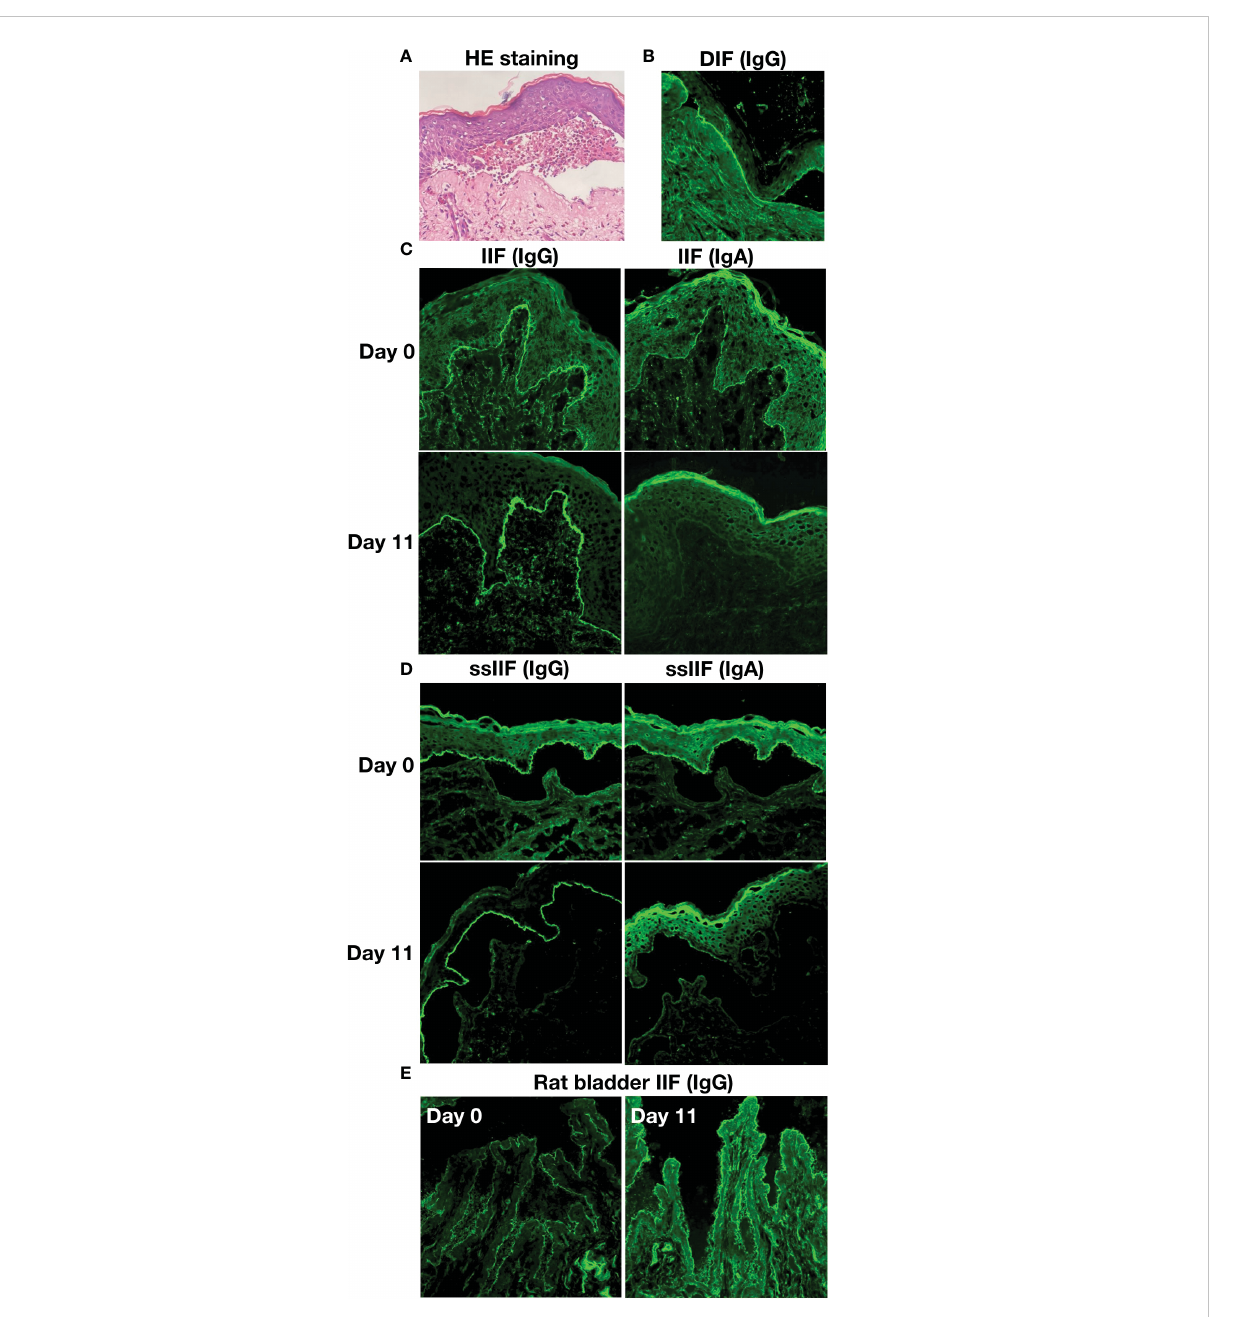
FIGURE 2 The results of histopathological and immuno fl uorescence tests of this patient. (A) Histopathological features of biopsy from lesioned skin on the left forearm (HE staining, original magni fi cation, x200). (B) Direct immuno fl uorescence (DIF) for IgG. (C) Indirect immuno fl uorescence with normal human skin (IIF) for IgG and IgA antibodies on Days 0 and 11. (D) IIF using 1 M NaCl-split normal human skin (ssIIF) for IgG and IgA antibodies on Days 0 and 11. (E) IIF using rat bladder tissue (Rat bladder IIF) for IgG antibodies on Days 0 and